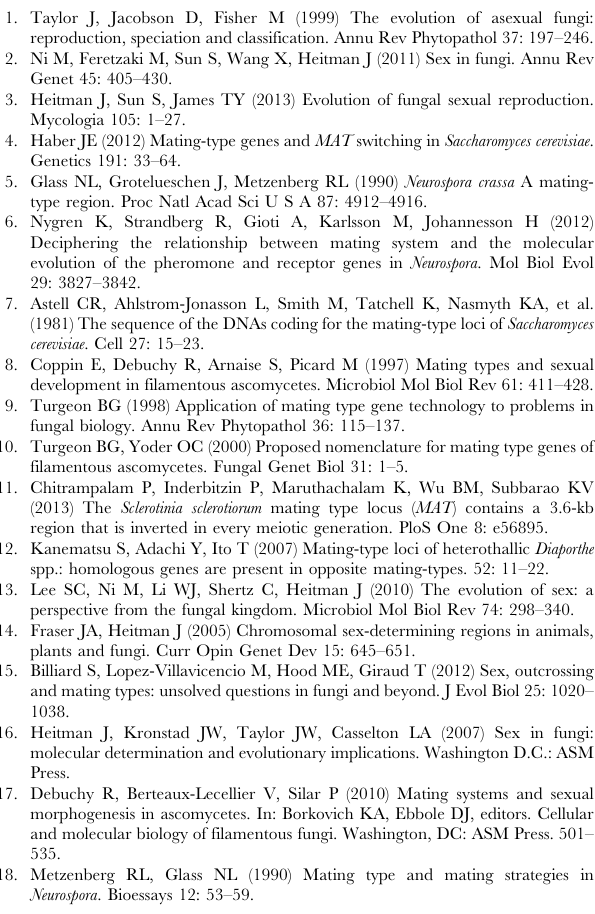
Table S2 Primers used to amplify fragments associated with the mating locus ( MAT-1 ) in Ceratocystis fimbriata . Table S3 Repeat regions identified using RepFind and REPuter. Table S4 Numbers and origins of the isolates of Ceratocystis fimbriata used in this